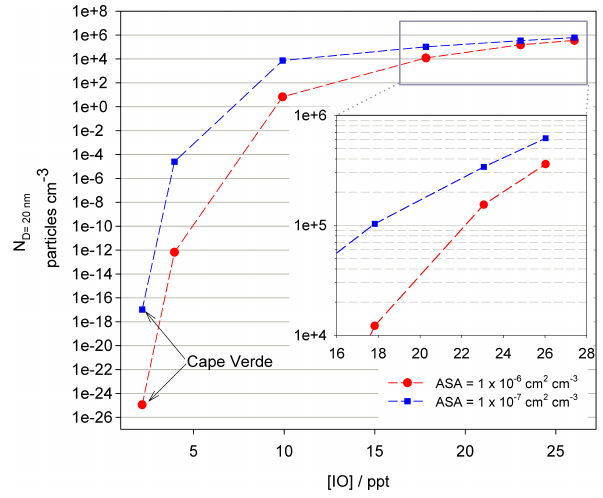
Fig. 7. The number of potential CCN formed at 10m after 24 h, as a function of the mean daytime IO mixing ratio at 10m. The [IO] is changed by altering the sea-to-air flux of I 2 species in addi- tion to the halocarbon flux as mentioned in Sect. 4.2. Two cases are illustrated in the figure to show the sensitivity to the back- ground aerosol surface area (ASA), which is set to a typical remote MBL value of 1 × 10 − 6 cm 2 cm − 3 (red) or an ultra-clean value of 1 × 10 − 7 cm 2 cm − 3